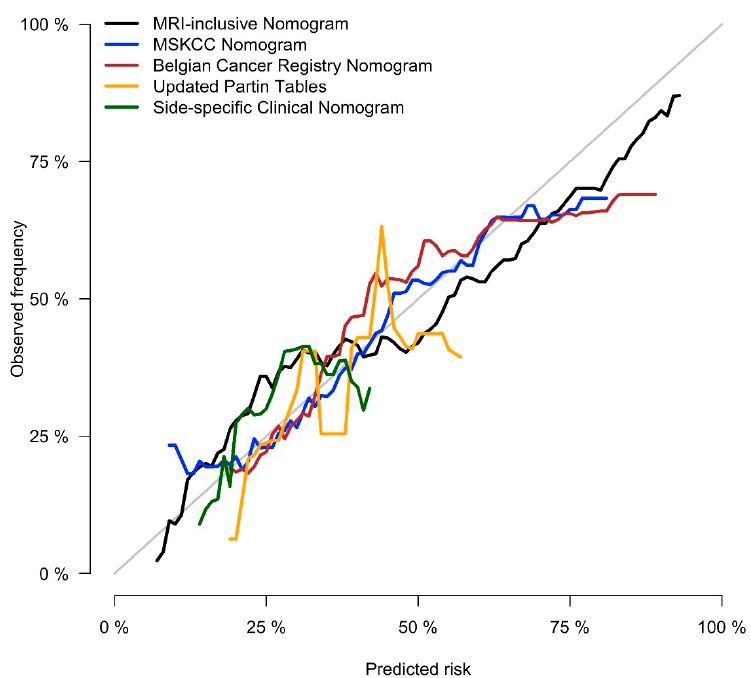
Figure 3. Calibration plot for the proposed MRI-inclusive nomogram and the benchmark models illustrating the actual frequency of EPE on the y -axis and the predicted probability on the x -axis (a more in-depth explanation can be found in [31]).